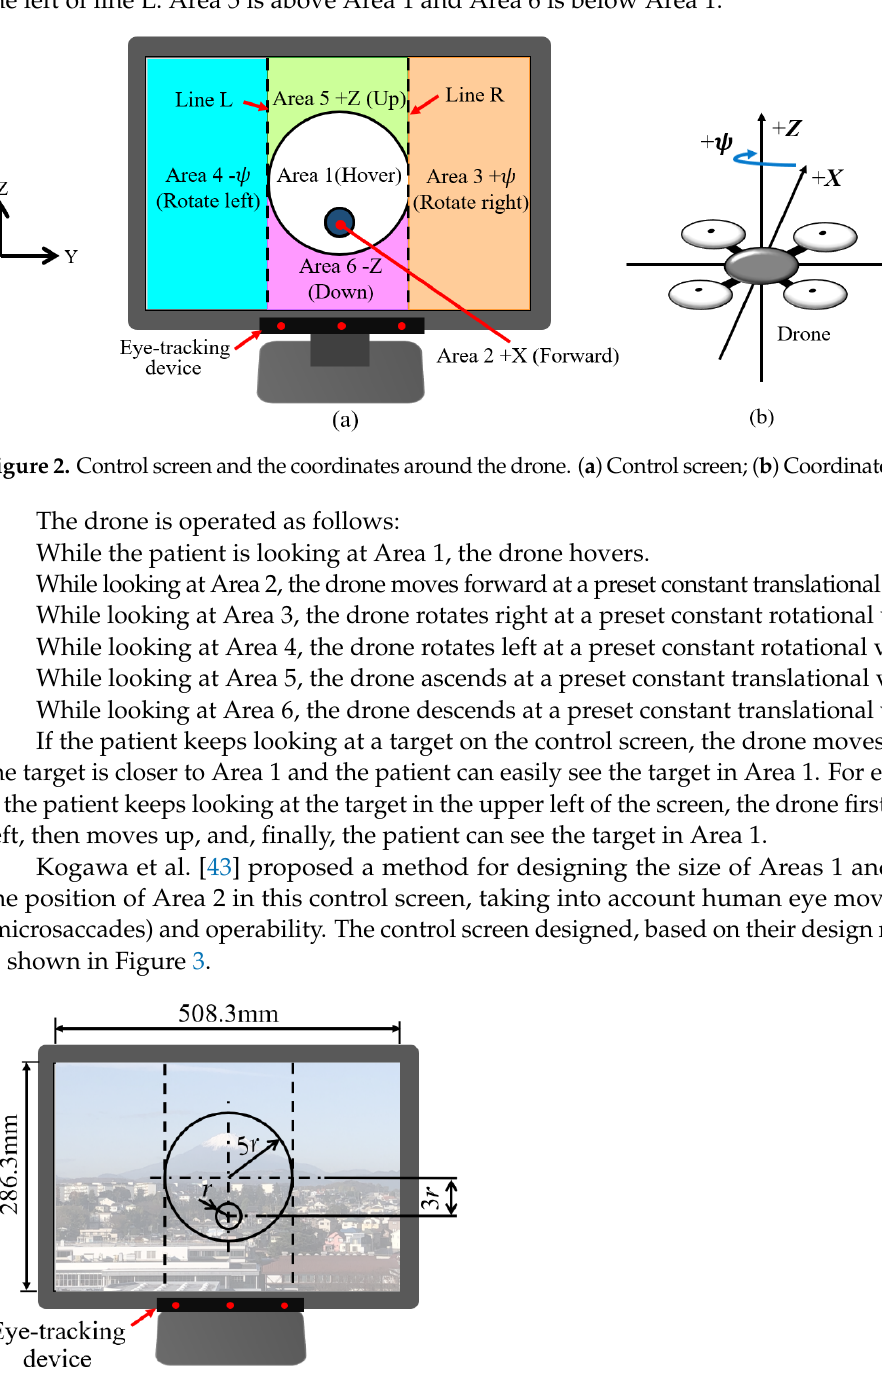
Figure 3. Control screen designed by Kogawa et al. [43].